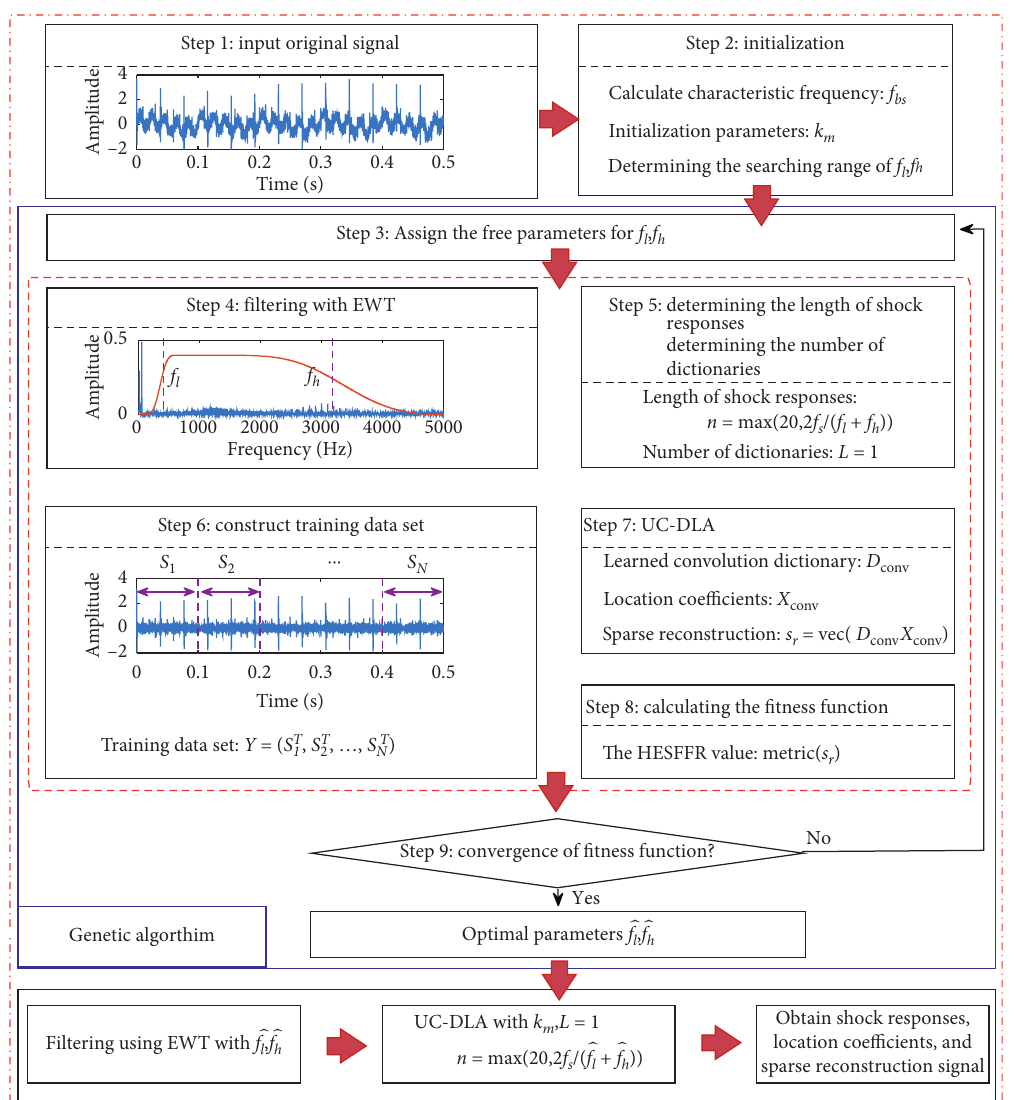
Figure 10: The procedure for the proposed